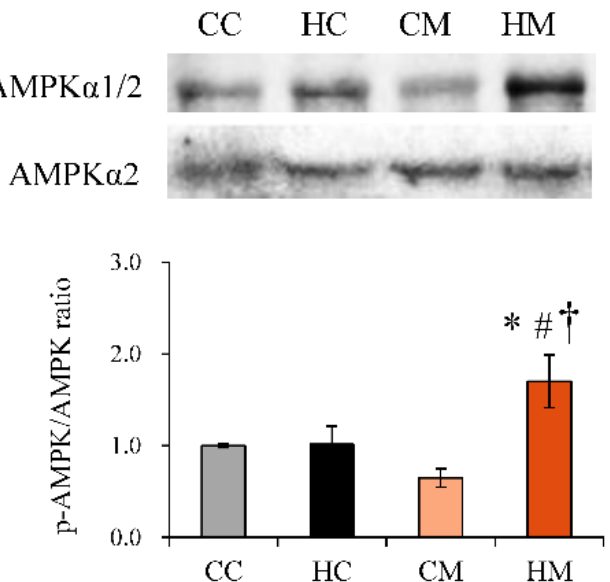
Figure 4. AMPK α 2 and AMPK α Thr172 phosphorylation protein abundance in placenta tissue of rats administered a maternal control diet (CC), maternal high-fat diet (HC), maternal control diet with metformin treatment (CM), or maternal high-fat diet with metformin treatment (HM). Representative immunoblots and densitometric quantification of AMPK α 2 and phosphor-AMPK α Thr172 protein are presented. Values are mean ± SEM. * Compared to the CC group, p < 0.05; # compared to the HC group, p < 0.05; † compared to the CM group, p < 0.05. Abbreviation: AMPK, adenosine monophosphate (AMP)-activated protein kinase.